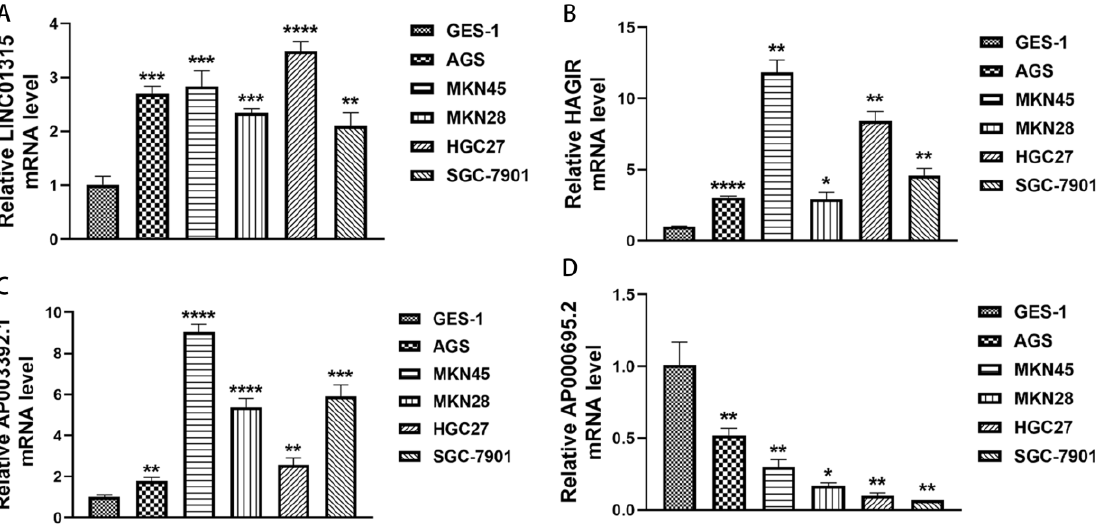
Figure 11. The expression levels of the PRlncRNA in the GC cell lines. ( A ) LINC01315. ( B ) HAGLR. ( C ) AP003392.1. ( D ) AP000695.2. * p < 0.05; ** p < 0.01; *** p < 0.001, and **** p <0.0001.